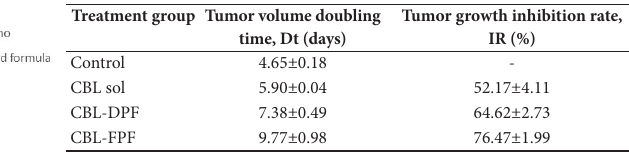
Table 1. Tumor Volume Doubling Time (Dt) and tumor Growth Inhibition Rate (IR%) Parameters After Injection of Normal Sa- line, CBL Solution, Targeted, and Nontargeted Formulations to the 4T1 Cells Tumor Bearing Mice.